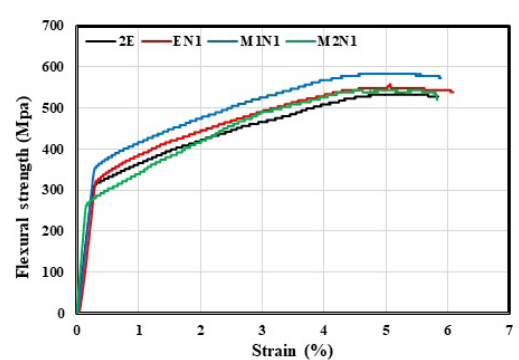
Figure 6. Flexural stress-strain curves of steel lined with epoxy filled with Al O 2 3